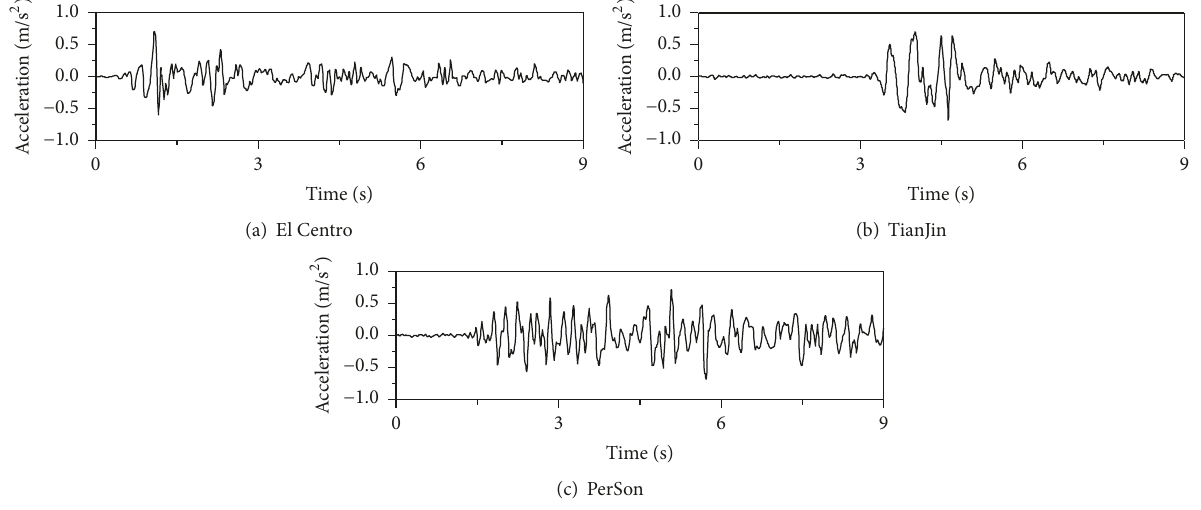
Figure 3: Acceleration time history curves of three ground motions.